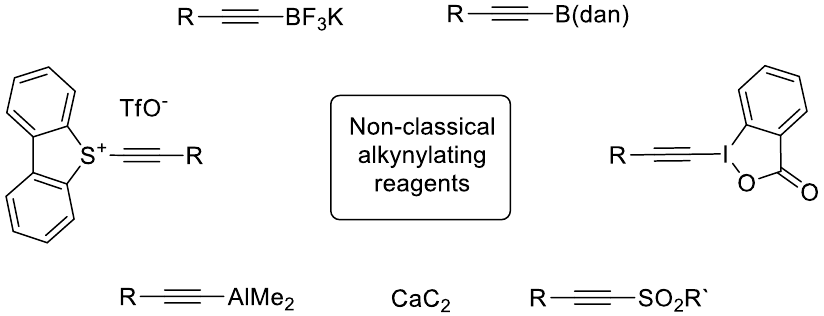
Figure 1. Examples of non-classical alkynylating reagents.